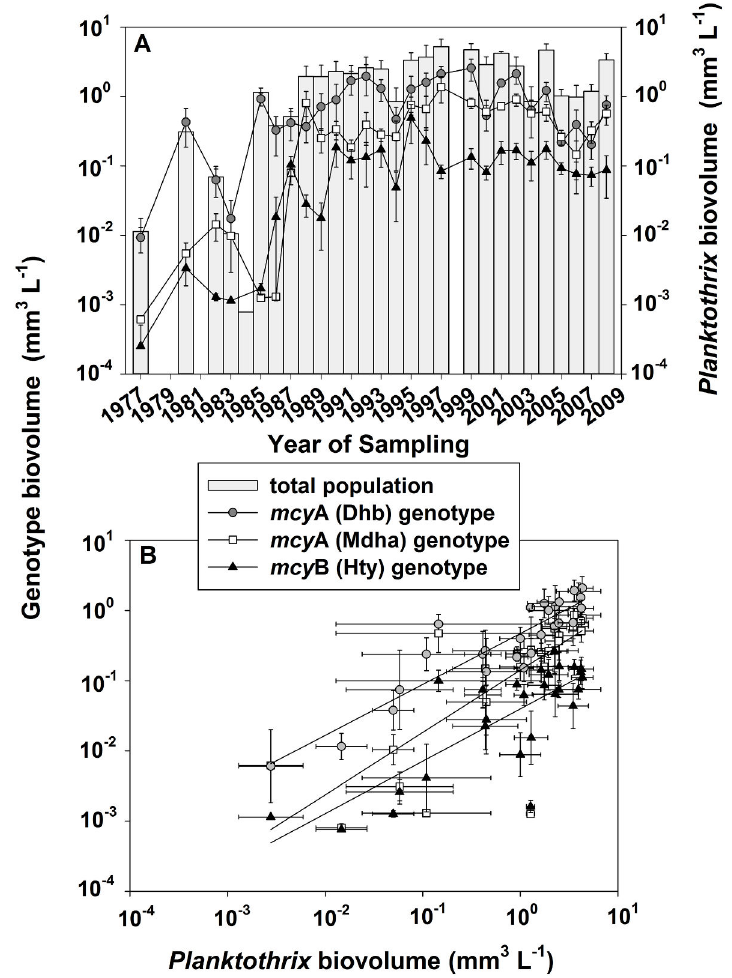
Figure 3. Dependence of mcy genotype biovolume on total population abundance as determined by qPCR in Lake Zürich. (A) Time course of annual mean ± SE abundance of the Dhb, Mdha, and Hty genotype and the total population biovolume (grey bars) of Planktothrix (mm 3 L -1 ). (B) Regression curves between Dhb, Mdha, and Hty genotype and the total population. For the regression curve details, see